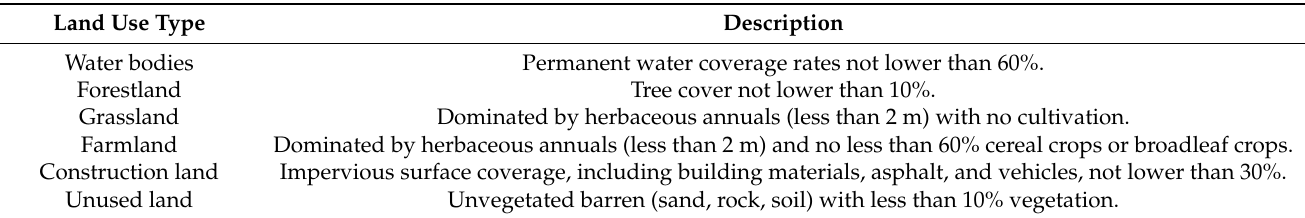
Table 2. Land use types and descriptions after